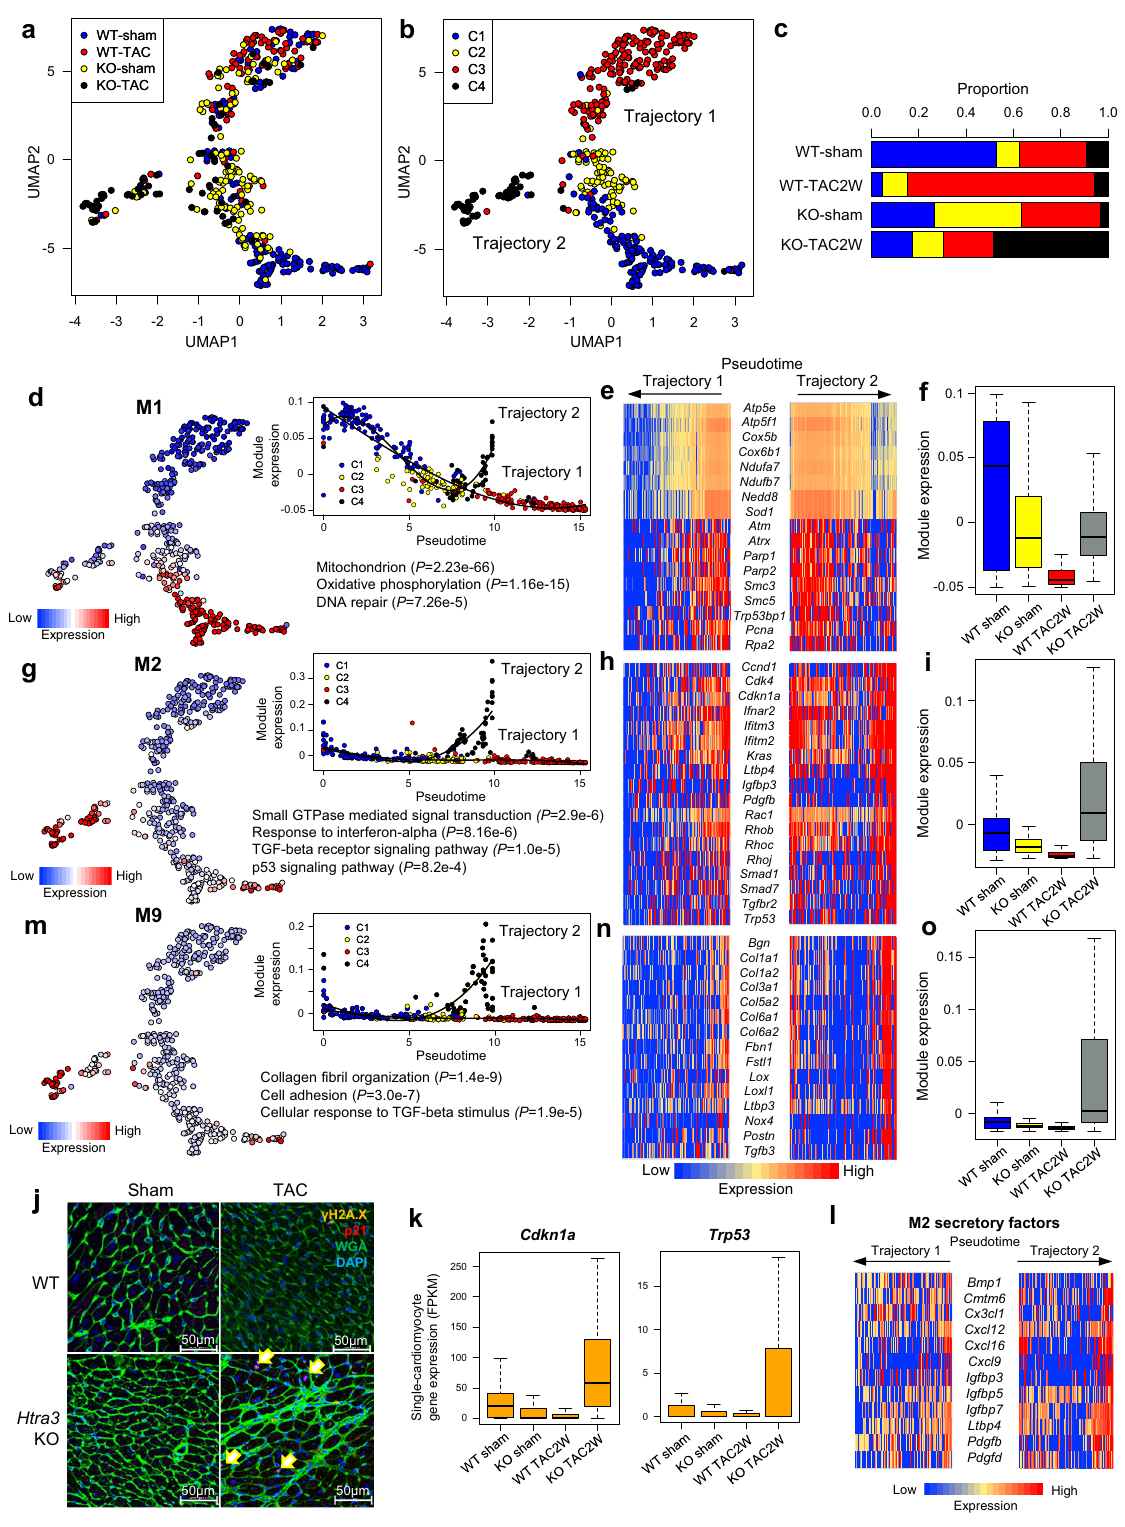
cardiac fi brosis but also cardiomyocyte secretory phenotype and bone marrow failure that TGF- β signaling-induced accu- through Htra3-TGF- β -IGFBP7 axis. Mechanical stress on fi bro- mulation of DNA damage is based on transcriptional repression blasts reduces expression of Htra3, leading to upregulation of of DNA repair genes 36,37 . Sustained activation of TGF- β signaling also activates expression of Nox4, a major source of oxidative TGF- β in the heart. Sustained activation of TGF- β signaling stress in the failing heart 33 , and promotes ROS production in represses expression of many DNA repair genes in cardiomyo- cytes, consistent with the previous fi ndings observed in cancer cardiomyocytes. These events collectively induce accumulation of NATURE COMMUNICATIONS| (2022) 13:3275